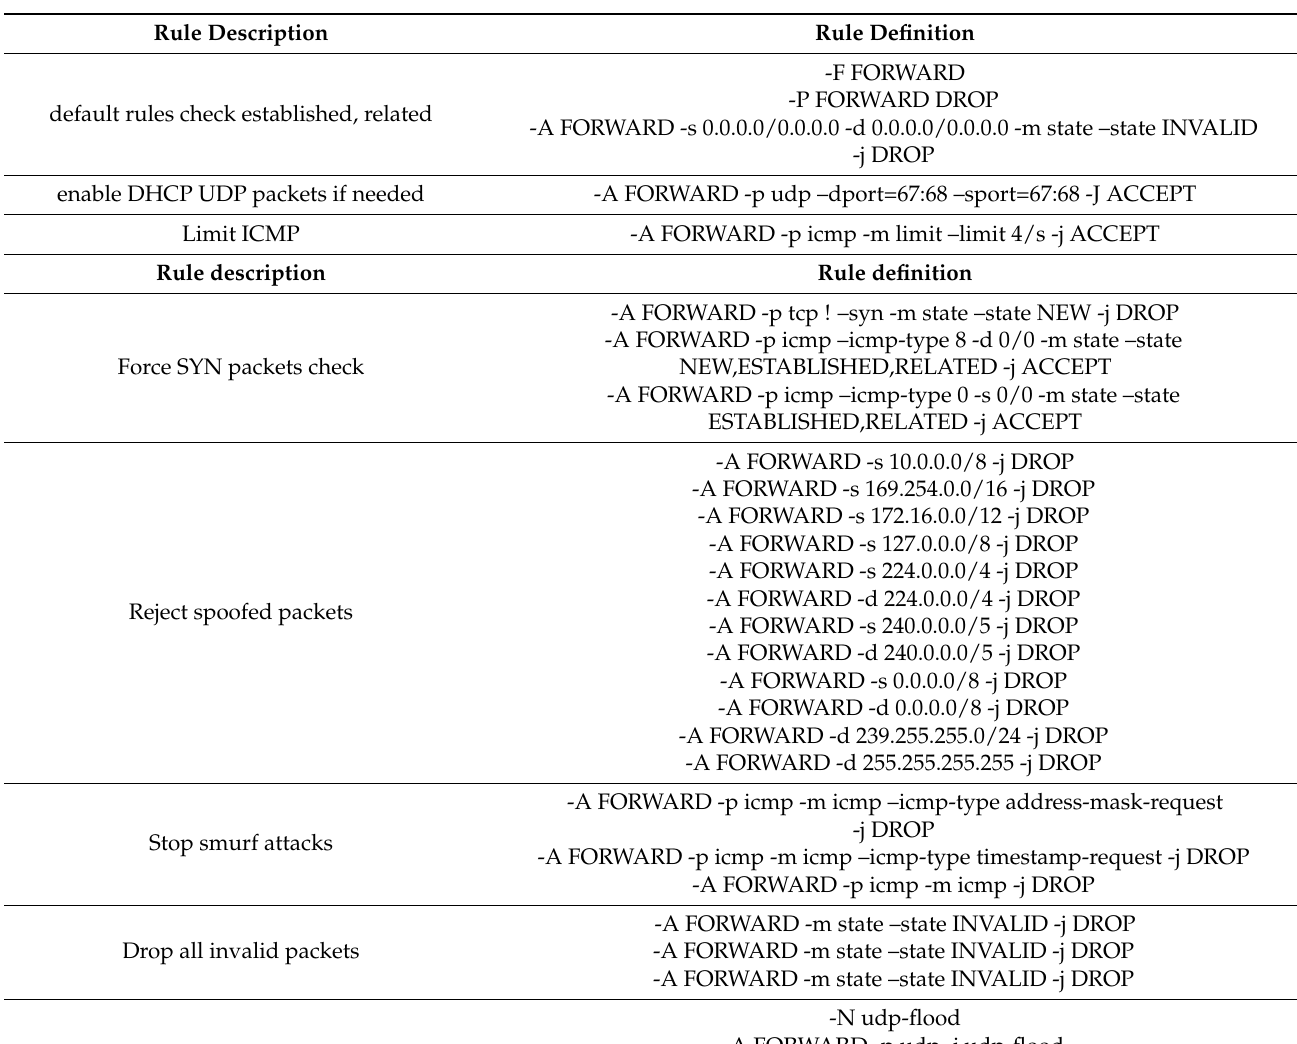
Table 4. IPtables firewall